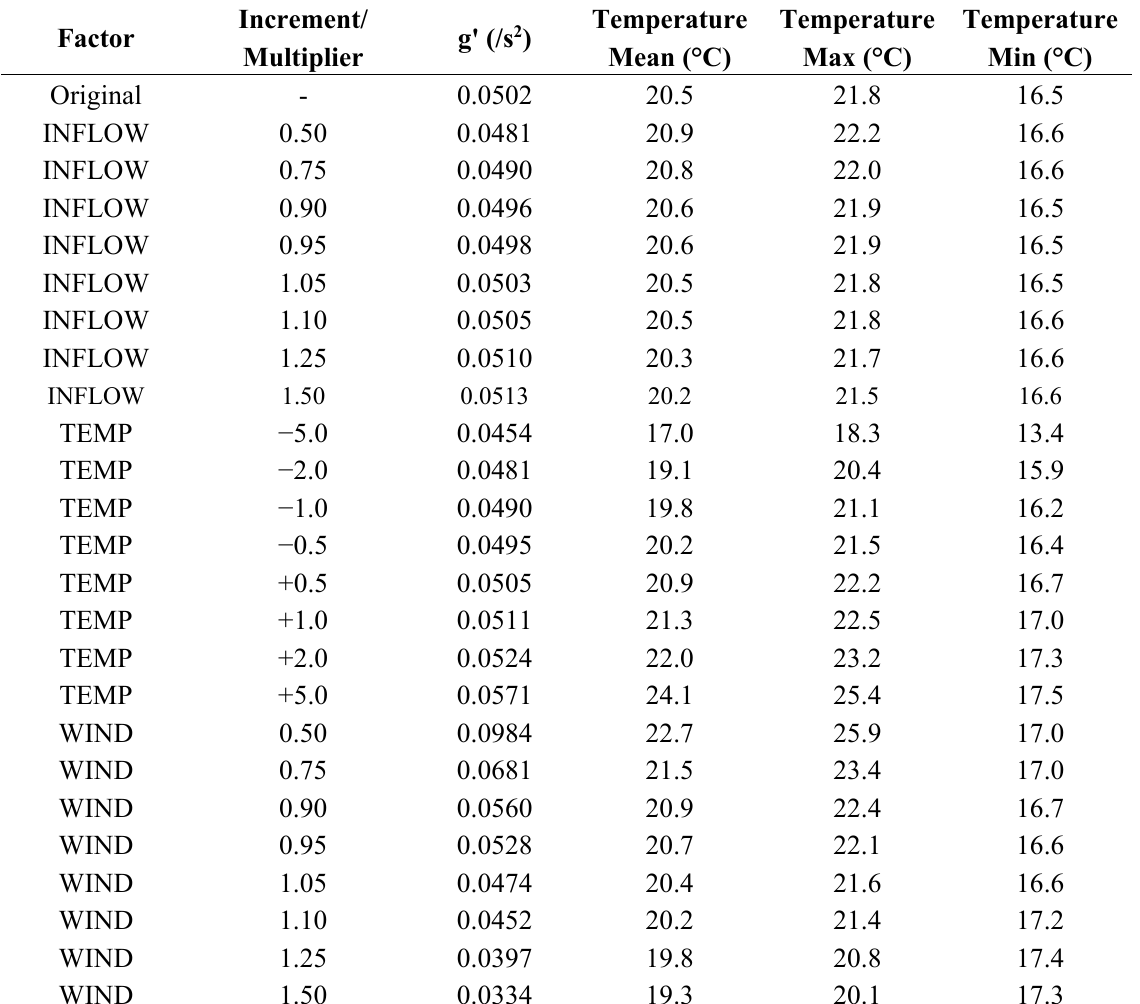
Table 3. Summary of average physical properties for climatic sensitivity analysis of ELCOM-CAEDYM simulations of Happy Valley